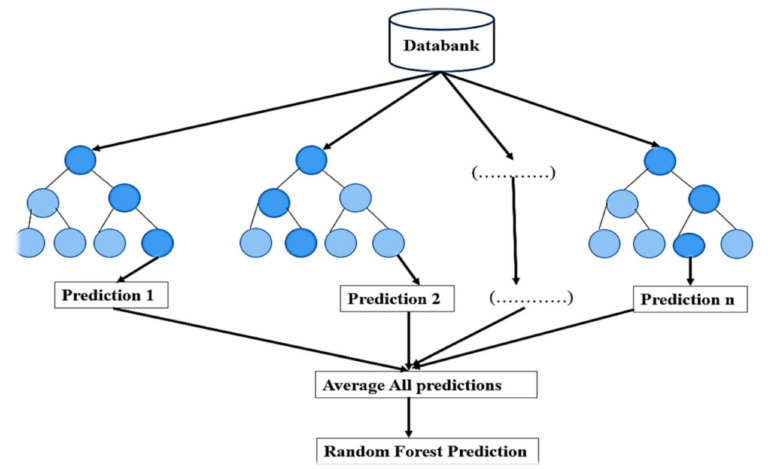
Figure 3. The schematic of the random forest technique for a regression problem. Solid color means that the prediction is correct, while the light color means that the prediction is